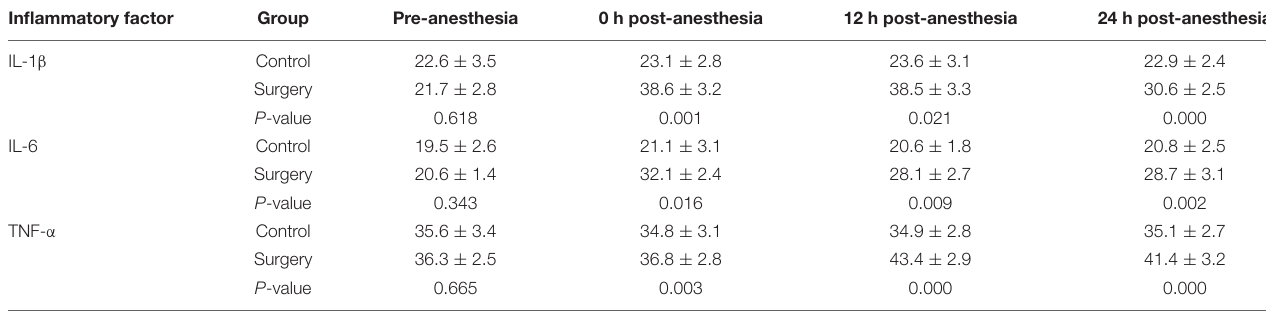
TABLE 6 | Comparison of serum inflammatory factors between the two groups. Inflammatory factor Group Pre-anesthesia 0 h post-anesthesia 12 h post-anesthesia 24 h